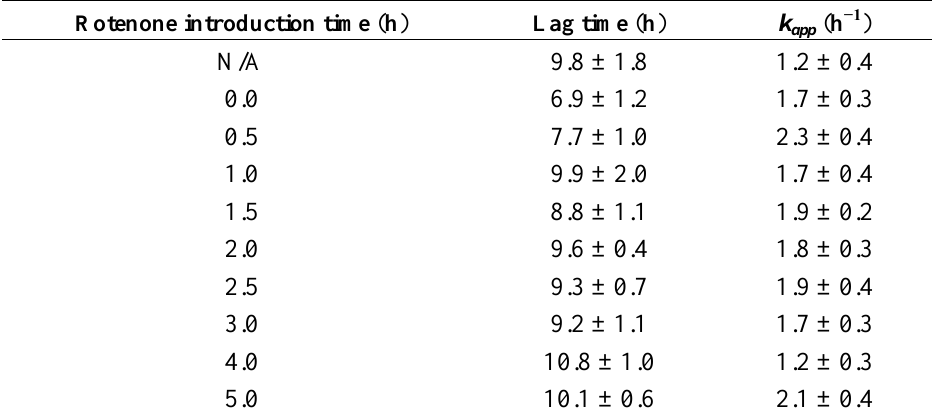
Table 1. Effects of added rotenone on kinetic parameters of α-synuclein